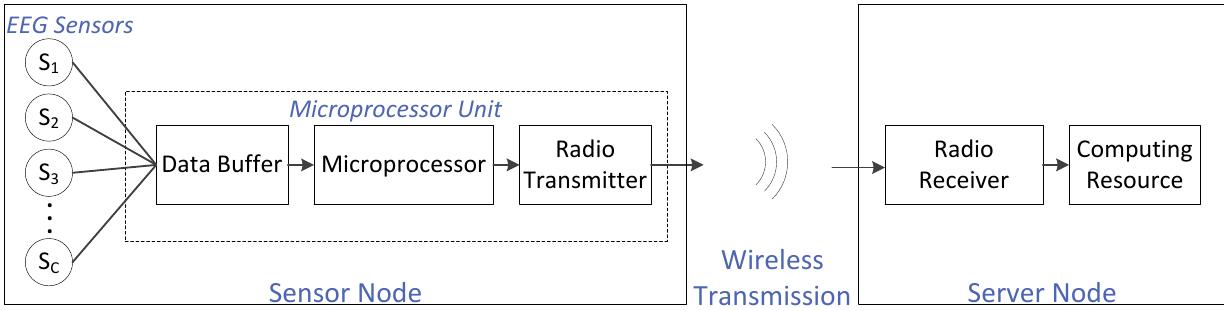
Figure 1. General block diagram for the electroencephalography (EEG) wireless body sensor network (WBSN)